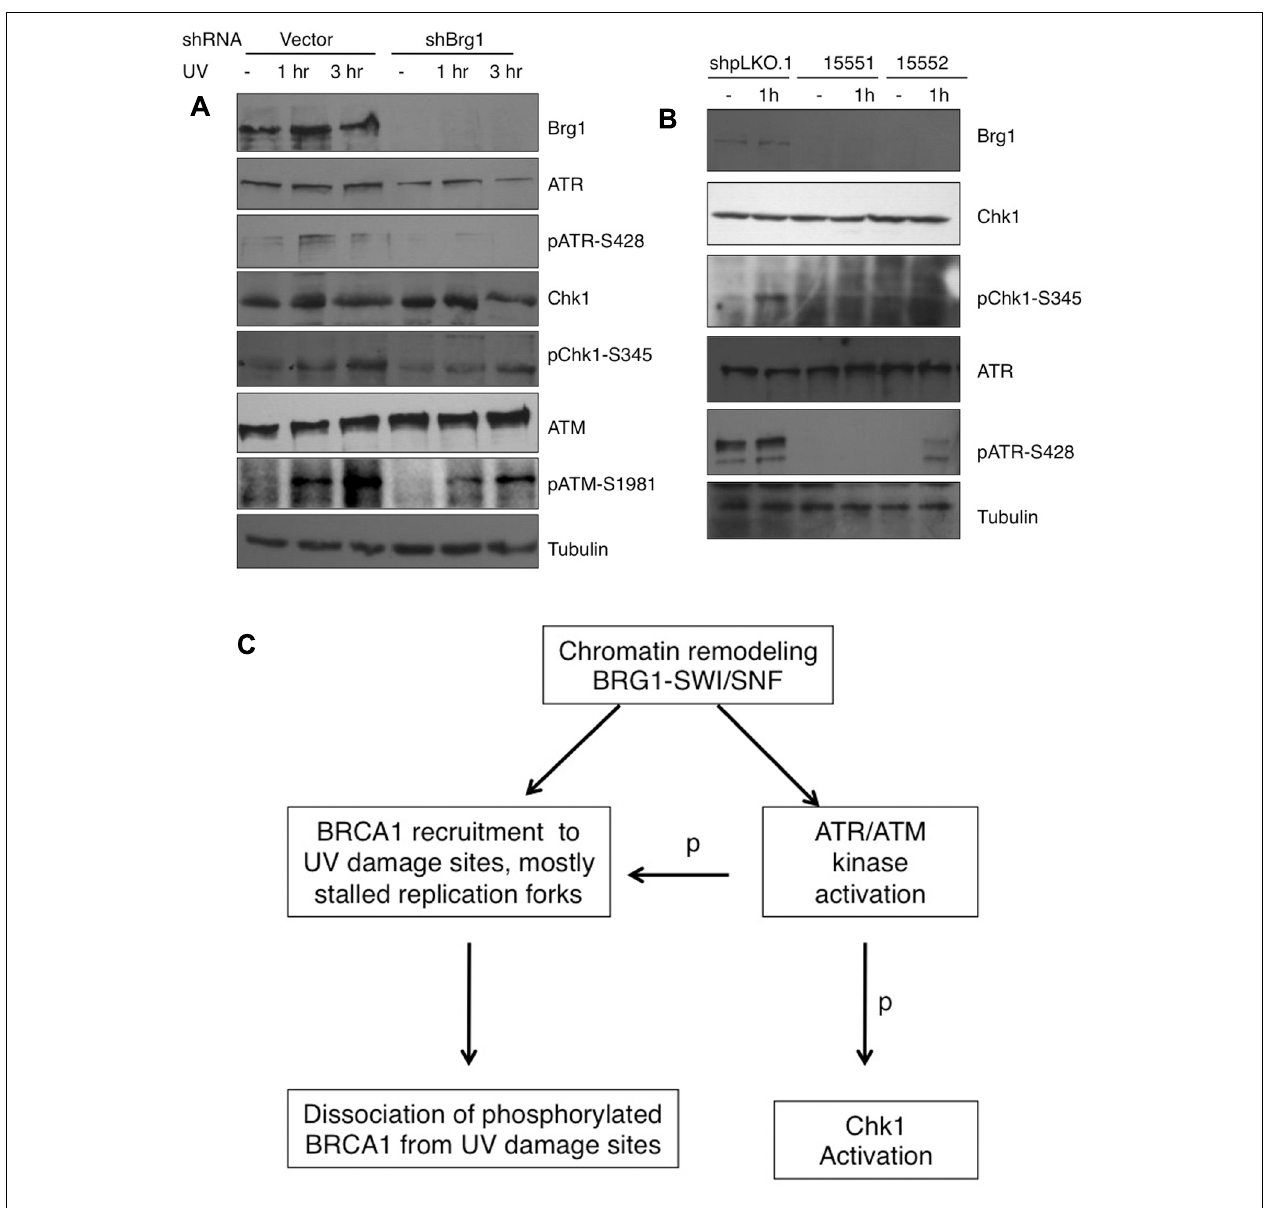
targeting BRG1 confirms the effect of BRG1 on ATR activation. (C) BRG1 is an upstream regulator of BRCA1 recruitment and ATR activation. BRG1 may facilitate BRCA1 recruitment to UV-stalled forks in replicating cells, through its chromatin remodel activity. In addition, BRG1 is upstream of ATR to modulate ATR activation and phosphorylation (p) of its downstream substrates, including RPA, BRCA1, and